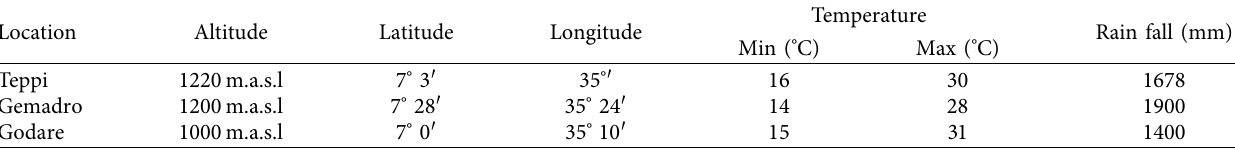
Table 1: Description of the study location.